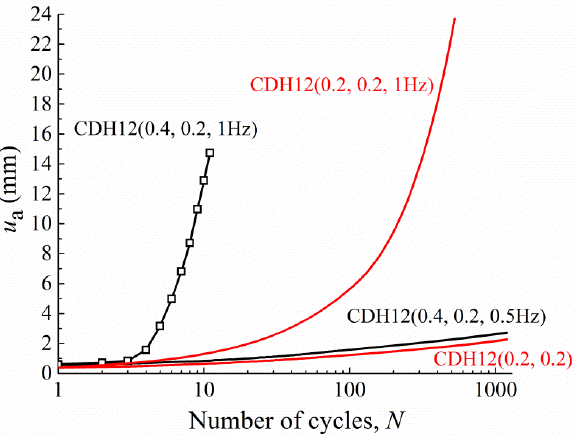
Figure 16 indicates that the displacement accumulation rate of anchor CDH12 (0.4, 0.2, 1 Hz) rises rapidly after the third cycle, and reaches 3.77 mm/cycle after 11 cycles. The development for anchor CDH12 (0.2, 0.2, 2 Hz) has the same trend as that for CDH12 (0.2,